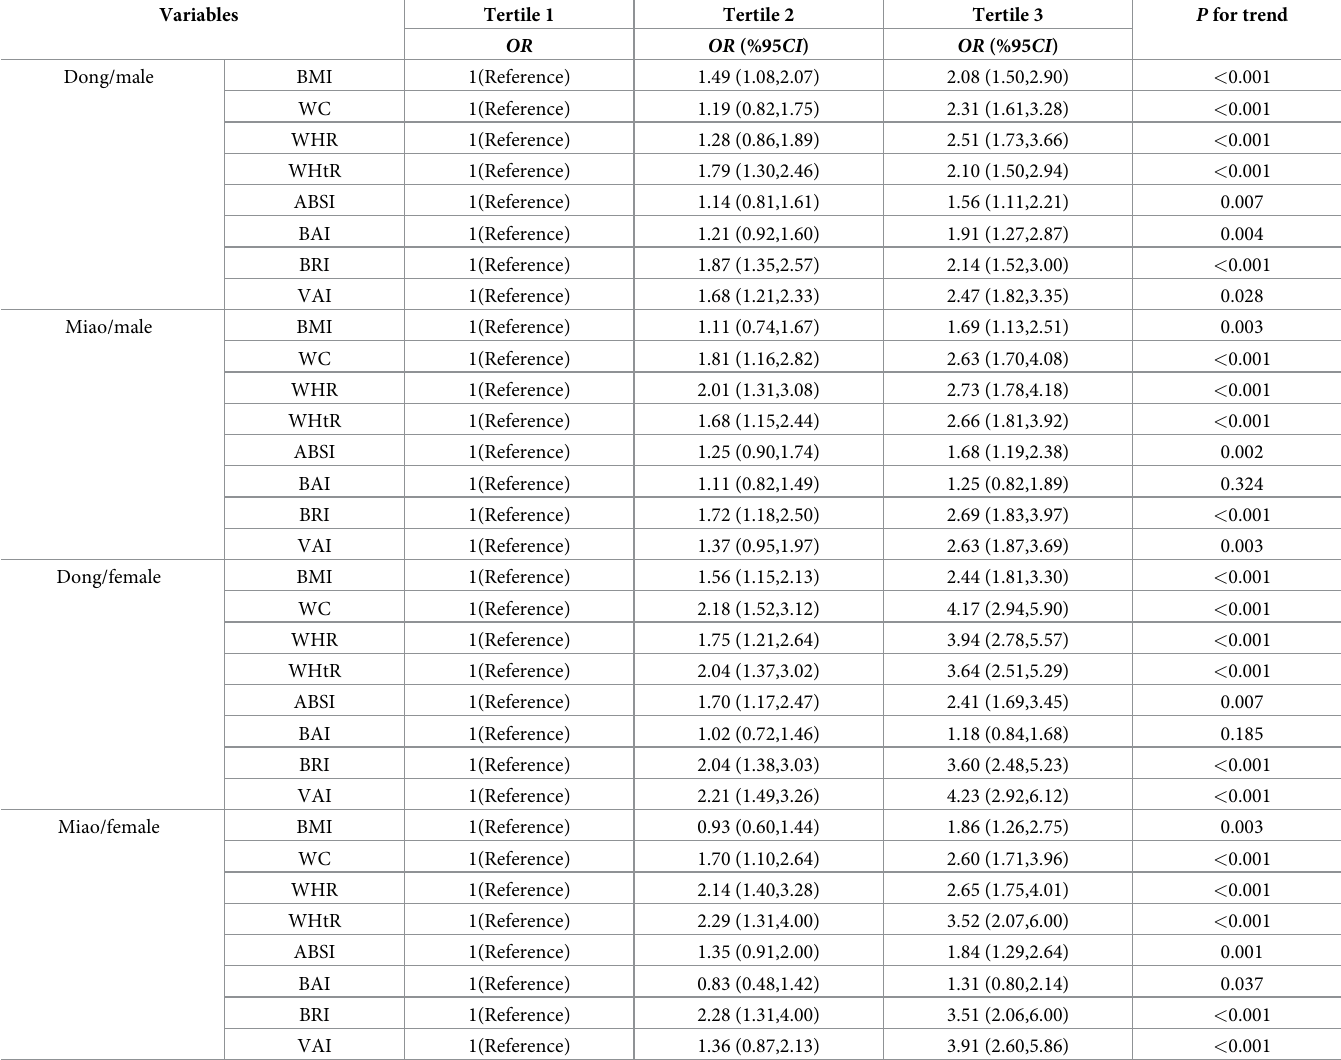
Table 2. Adjusted associations between anthropometric indices and